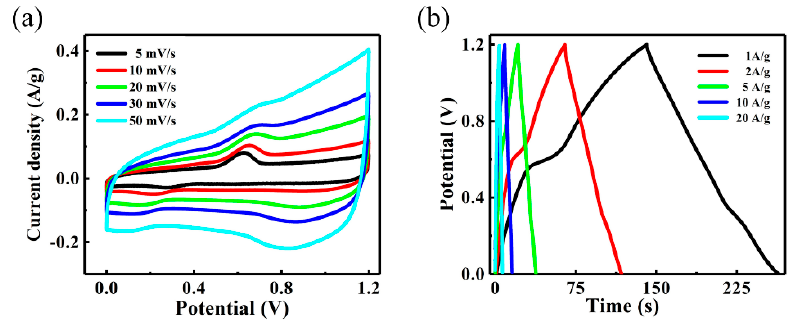
Figure 6. Electrochemical performance of NiMoO 4 @NiMoO 4 nanosheet-on-nanowire arrays (SOWAs) // alternating-current (AC) asymmetric hybrid supercapacitor (ASC). ( a ) CV curves at various scan rates; ( b ) GCD curves at various current densities.